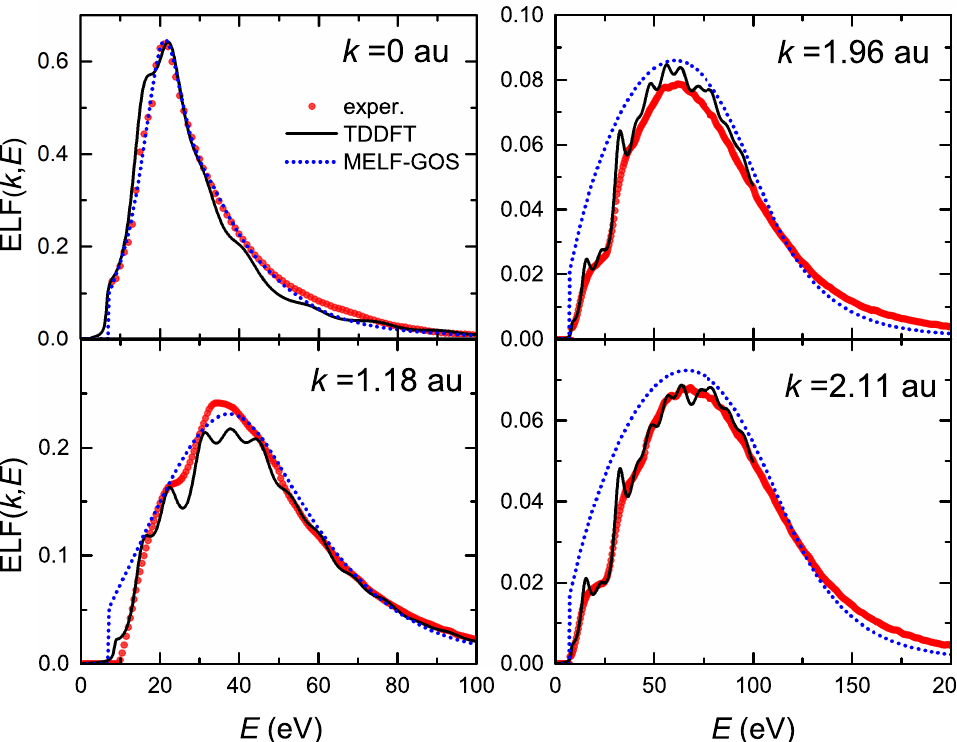
Figure 1. Energy loss function (ELF) of liquid water as a function of the energy transfer E at several momentum transfers ¯ hk from LR-TDDFT (black solid lines) and from MELF-GOS (blue dotted lines) approaches. Red circles correspond to experimental data